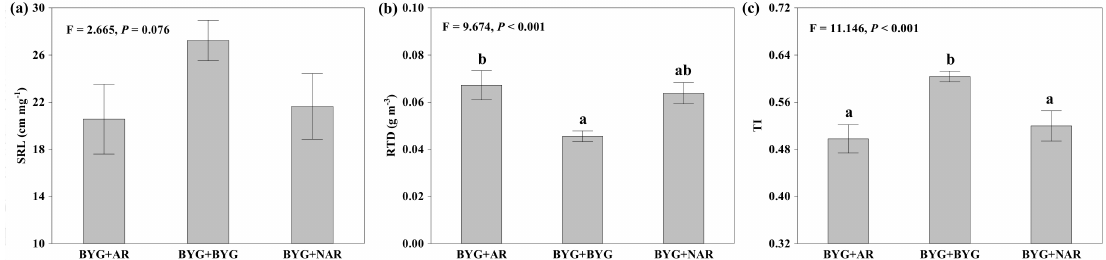
Figure 2. Specific root length ( a ), root tissue density ( b ) and topological index ( c ) on barnyardgrass grown as a monoculture (BYG + BYG), as mixed cultures with allelopathic rice (BYG + AR) and nonallelopathic rice (BYG + NAR). Each value is the mean ± SE. Bars with different letters are significantly different at the p < 0.05 level according to Tukey’s